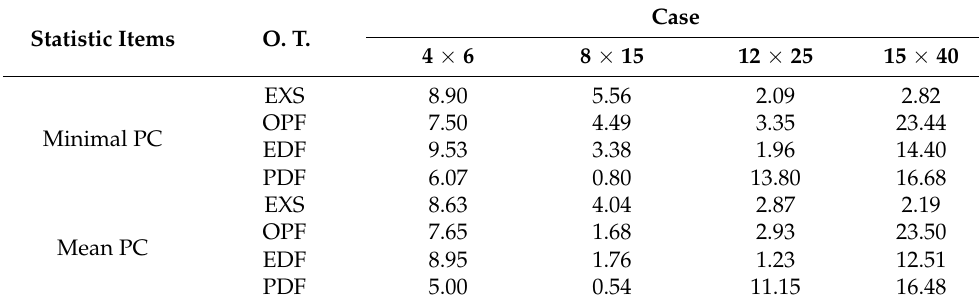
Table 10. rpds (%) of operation time policy experiments with PSV as the benchmark.